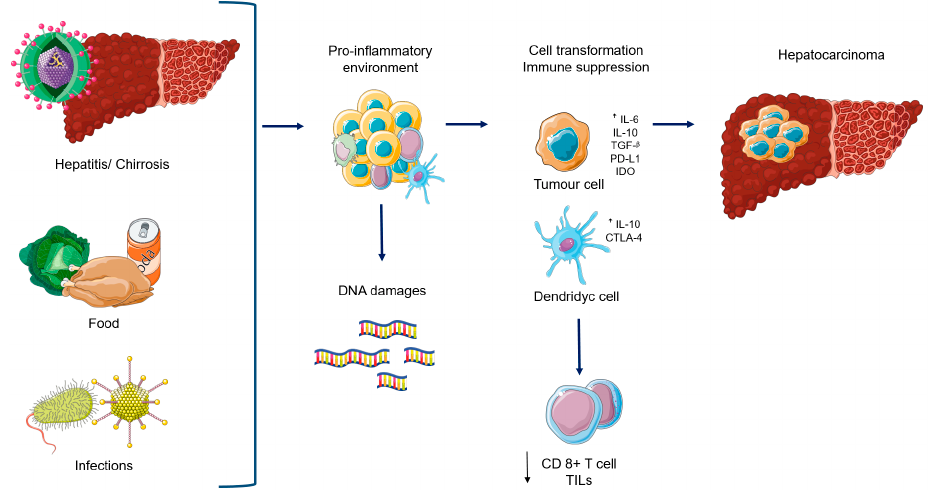
Figure 1. Biological rational to use Immune checkpoint inhibitors in Hepatocellular carcinoma.